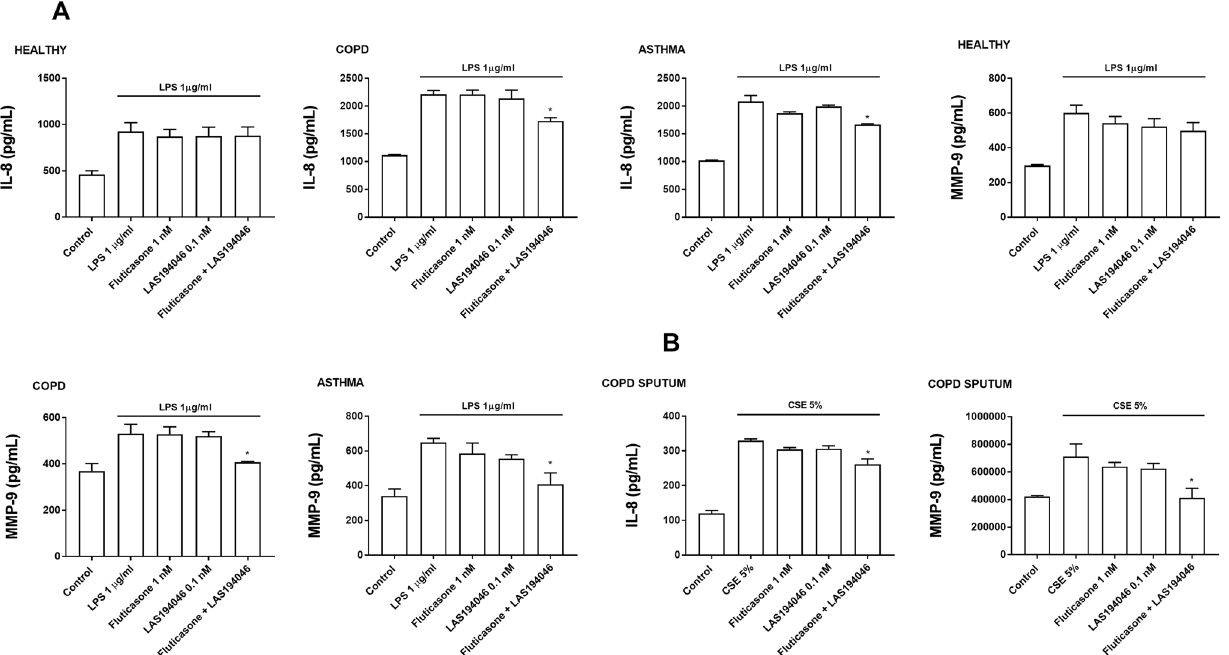
Figure 4. LAS194046 and fluticasone propionate combination shows additive/synergic effects on human neutrophil inflammation. Neutrophils from healthy subjects, severe asthma and COPD patients were pre- incubated with sub-effective concentrations of LAS194046, fluticasone propionate or its combination during 1 h followed by cell stimulation with ( A ) LPS (1 µg/ml) or ( B ) cigarette smoke extract (CSE 5%) for 6 h to measure IL-8 and MMP-9 release. The results are expressed as the mean ± SD (n = 3 each for cells from healthy controls, severe asthma and COPD patients in independent experiments with triplicate samples). A two-way ANOVA was followed by a post hoc Bonferroni test. *p < 0.05 vs. cells from healthy